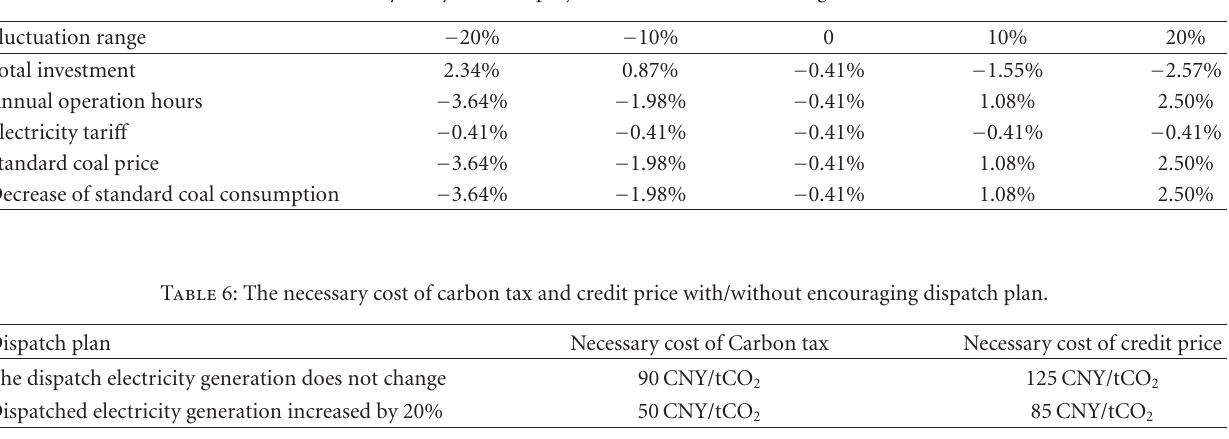
Table 5: The sensitivity analysis of the project within a fluctuation range from − 20% to 20%.